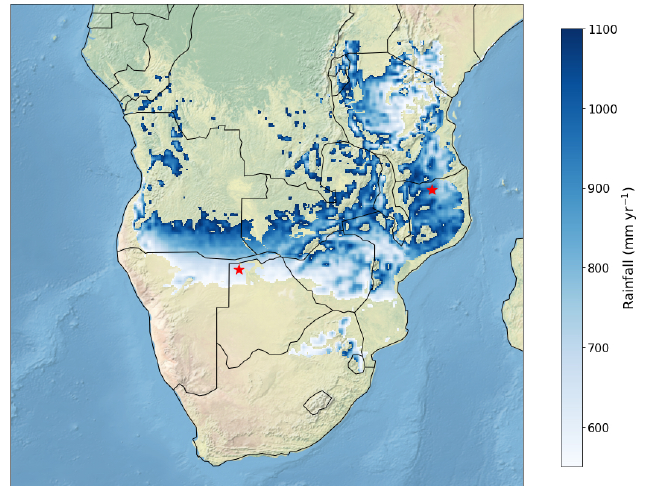
Figure 1. Study regions (red stars) and rainfall in areas classified as “Tropical and Subtropical Grasslands, Savannas and Shrublands” [24] falling within the rainfall range of the two study regions (i.e., 550 mm–1100 mm y − 1 on average over the period 2002–2016).